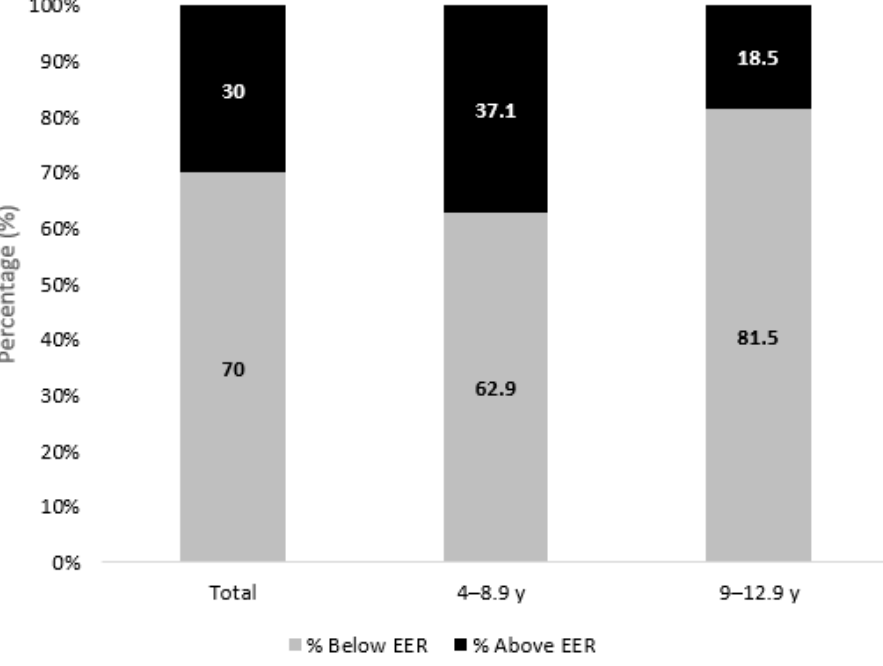
Figure 4. Proportions of UAE Children aged 4 – 12.9 years Consuming Above and Below the EER, KNHS 2021. Significant differences were observed between the two age groups with p <